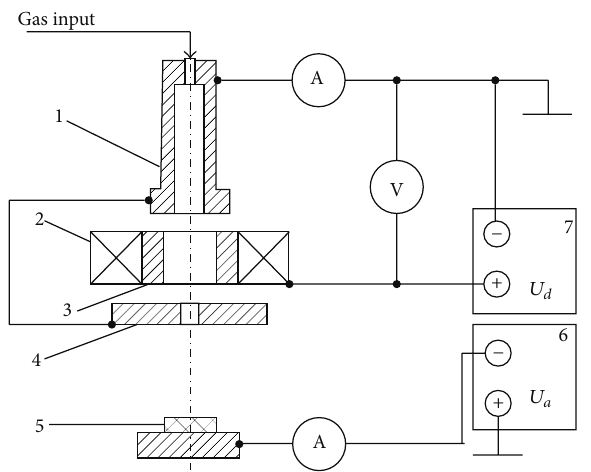
Figure 1: Schematic diagram of the reactive ion-beam deposition system. 1: hollow cathode; 2: magnet; 3: anode; 4: reflector cathode; 5: substrate; 6, 7: power supply sources.